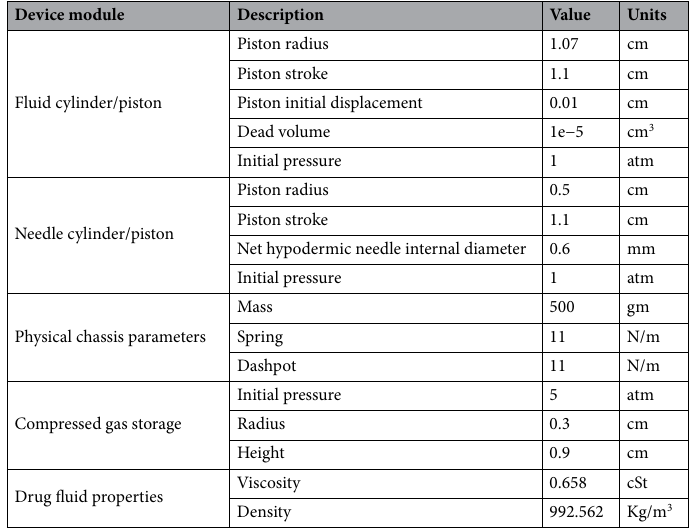
Table 1. Simulation and device